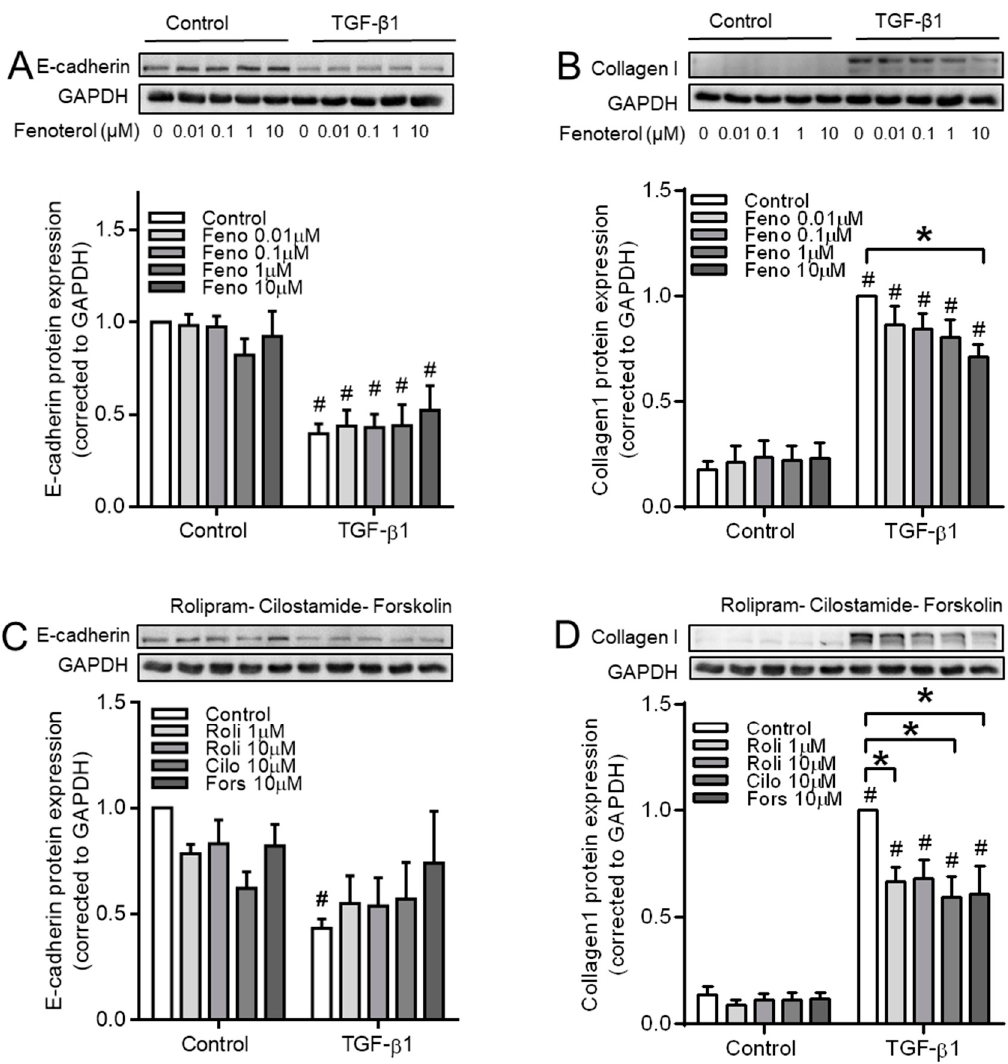
Figure 11. Effect of fenoterol, rolipram, cilostamide and forskolin on TGF- β 1-induced EMT makers using BEAS-2B cells. ( A – D ) Representative western blotting images and quantification of E-cadherin ( A , C ) and collagen Ӏ ( B , D ) in cells pre-incubated with fenoterol ( A , B ) or rolipram, cilostamide and forskolin ( C , D ) before TGF- β 1 treatment. Data represent 5–6 independent experiments. Data are expressed as mean ± SEM, * p < 0.05; significant difference between indicated groups. # p < 0.05; significant difference between with or without TGF- β 1 treatment.